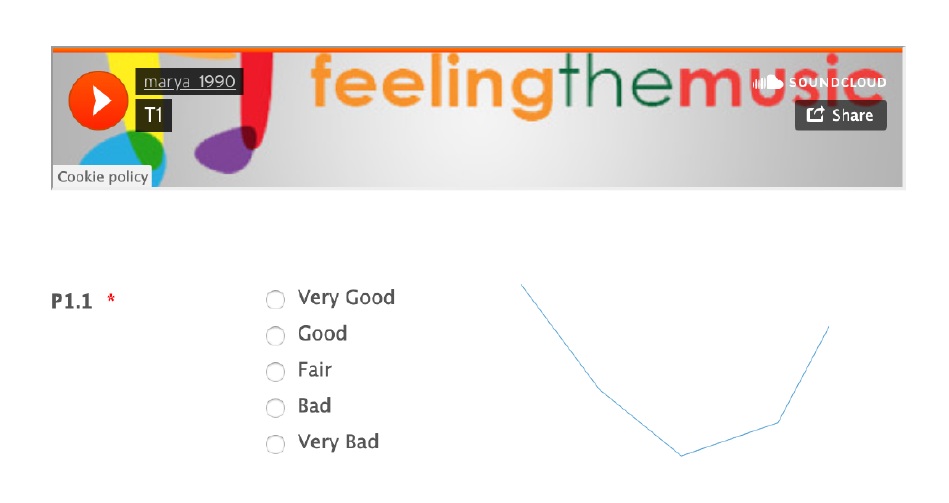
Figure 5. Shows the results of the fitness value proposed by ChordAIS-Gen against the users’ subjective ratings. The red * symbol means this question is mandatory to finish the listening